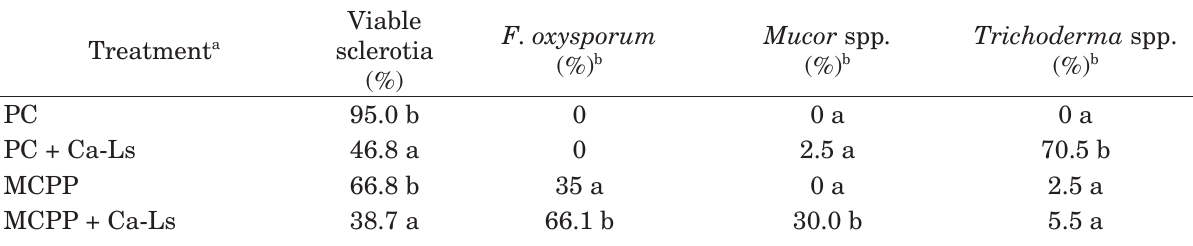
Table 3. Percent of viable sclerotia of S. sclerotiorum and incidence (%) of potential parasite, F. oxysporum, Mucor spp., and Trichoderma spp. recovered from dead sclerotia, 30 days after their burial in the organic substrates PC (88% peat + 12% coconut fibres) and MCPP (25% municipal compost + 15% peat + 60% pumice) or sterile sand and PC